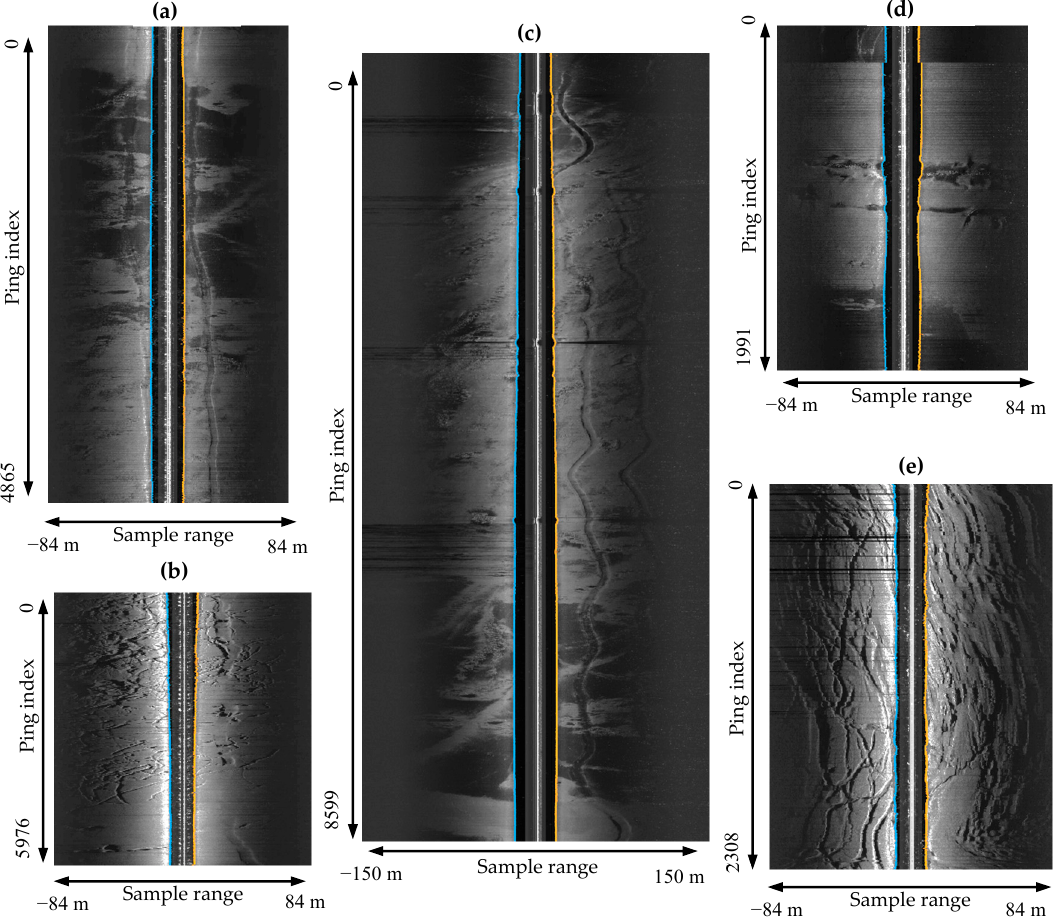
Figure 11. Sea bottom detection and tracking of other survey lines in Meizhou Bay. Panels ( a – e ) are the corresponding bottom detection results represented on the waterfall image of five survey lines.